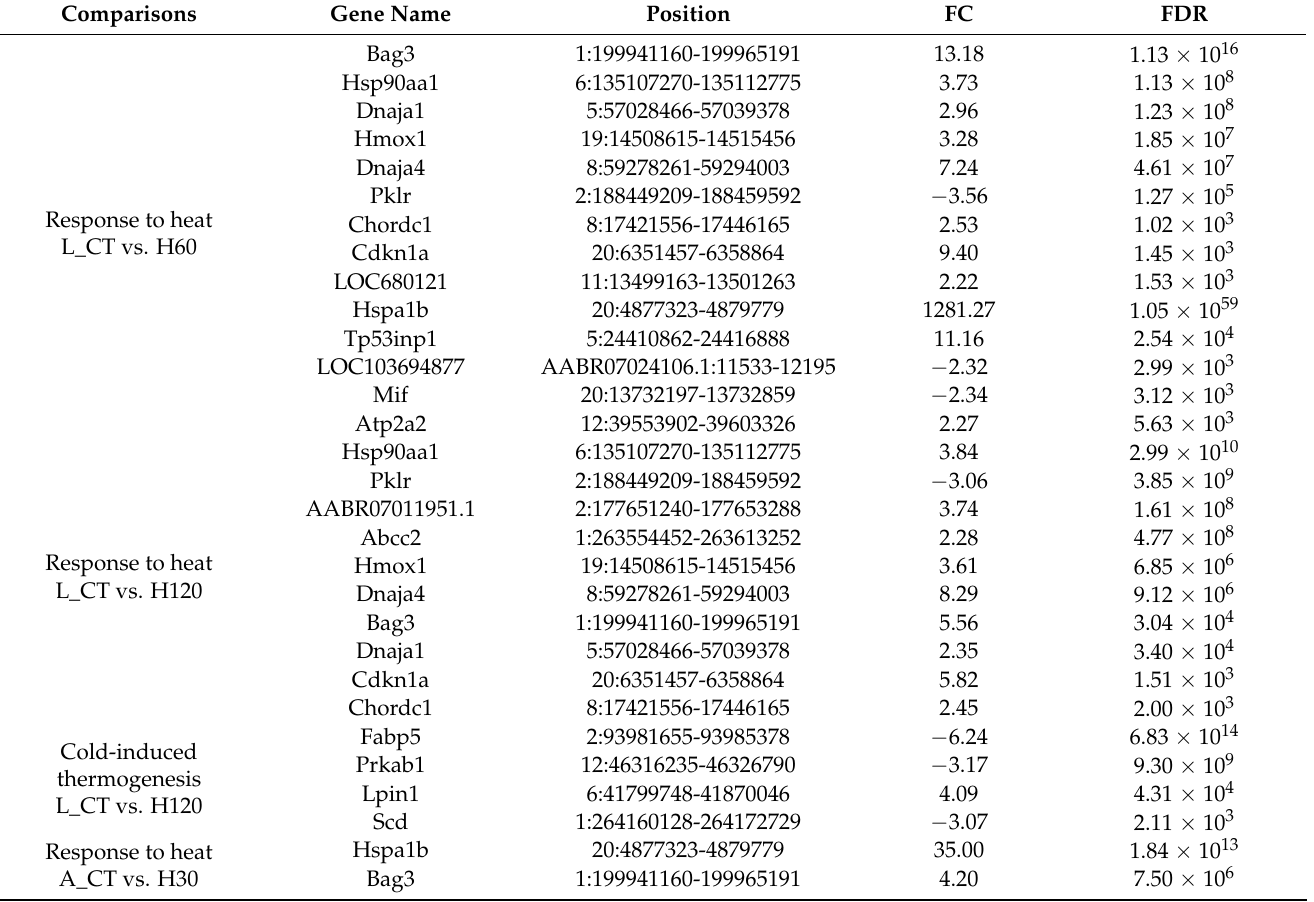
Table 6. Summary of the DEIDEGs enriched in processes of response to heat- and cold-induced thermogenesis under heat